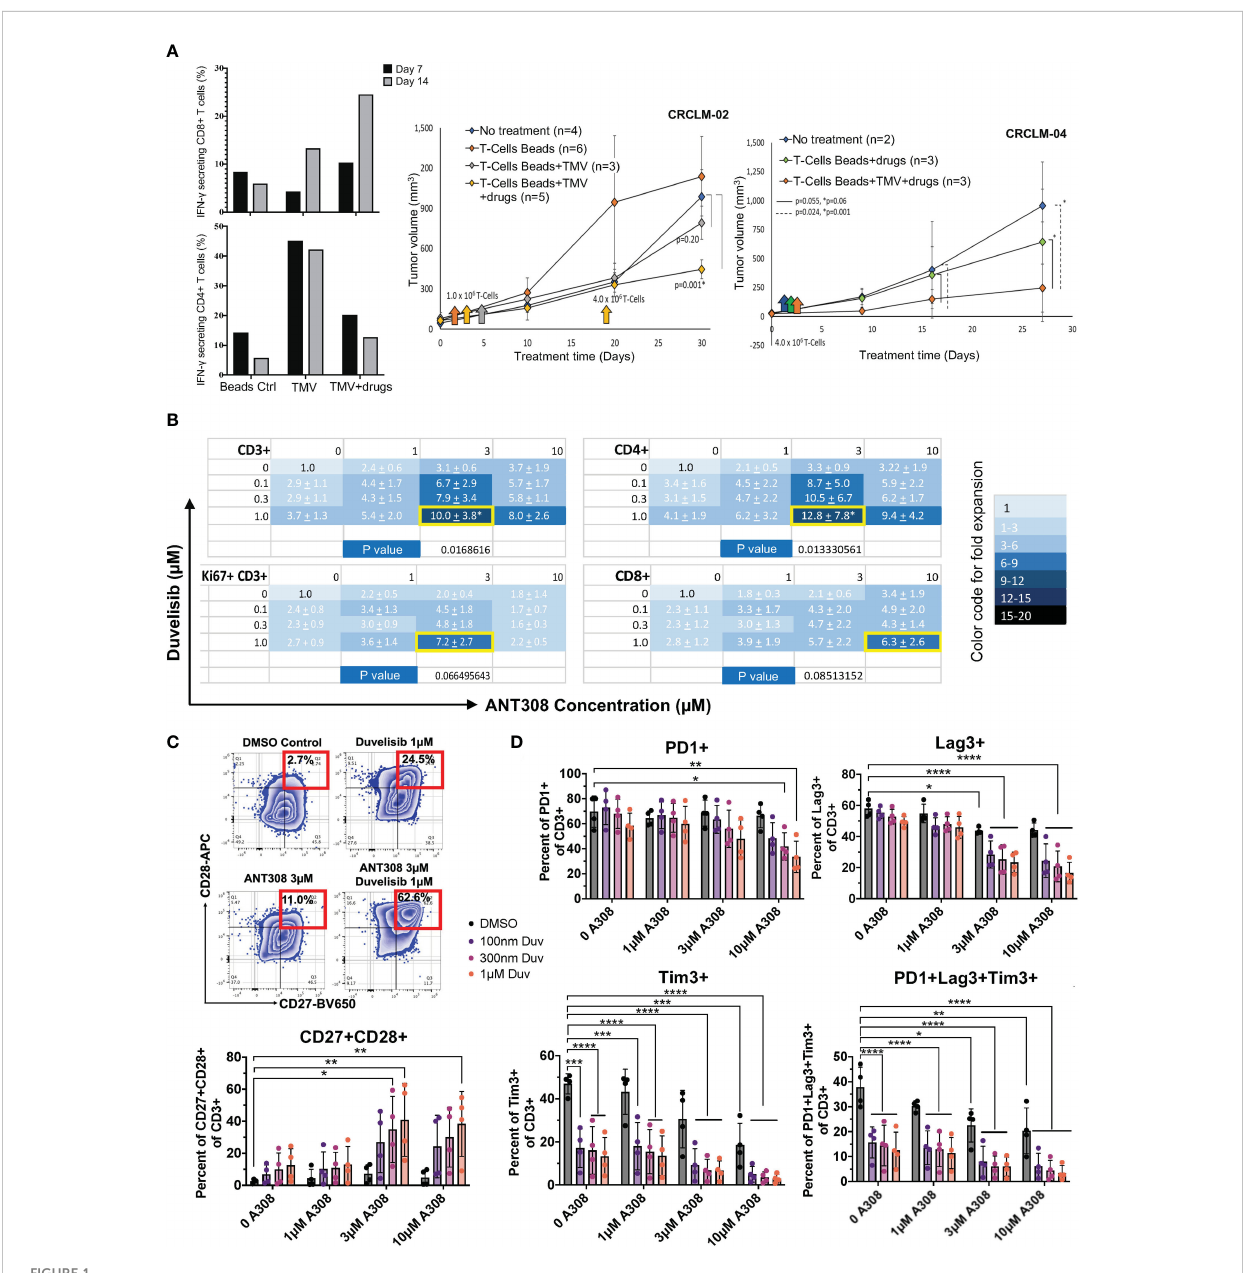
FIGURE 1 Pharmacological blockade of PI3K and VIPR signaling improves T-cell expansion and function in vivo ( (A) adoptive antigen-speci fi c T cells in metastatic colon cancer PDX model) and in vitro ( (B – D) , human T cells). (A) Left: Increased IFN- g secreting CD8+ T cells using decorated TMV with VIPhyb and idelalisib (CRCLM-02, n=1); Right: Decreased tumor growth in PDX (CRCLM-02 and CRCLM-04) mice receiving T cells expanded with beads+TMV+drugs. ANOVA was used to determine signi fi cance. The standard error (SE) was shown. (B) Total CD3+ T cells, the actively proliferating Ki67+CD3+ subset, CD4+CD3+ T cells, and CD8+CD3+ T cells are synergistically expanded in vitro by the combination of ANT308 and duvelisib. The mean +/- SD fold increase in cell expansion over control cultures containing neither added ANT308 nor duvelisib is shown (n=4), with color shading according to the relative increase. The pair of concentrations yielded the maximal increase in mean fold expansion is shown with a yellow border around the cell. (C) Frequencies of CD27+CD28+ T cells in cultures with duvelisib and ANT308 led to the highest average expansion for that subset of T cells (n=4). An example of gating is on the left. (D) ANT308 and duvelisib demonstrated synergy in decreasing PD1+, Lag3+, Tim3+, and PD1+Lag3+Tim3+ cells (n=4). Figures were plotted with Microsoft Excel and Prism 9. Paired two-sided student t-test was used to determine signi fi cance. *p<0.05, **p<0.01, ***p<0.001, ****p<0.0001